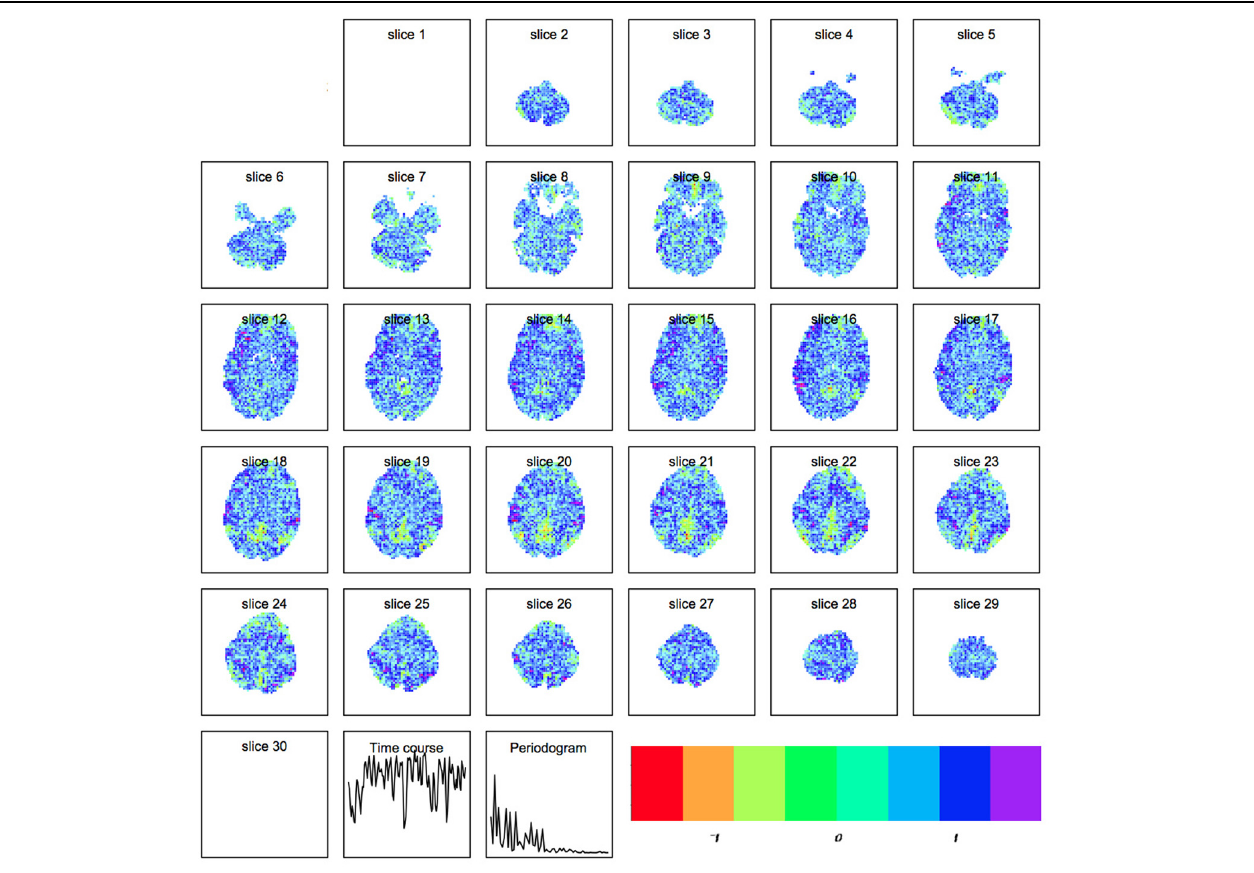
FIGURE 2 | Spatial map produced by independent components analysis within R. Each component is a set of spatially weighted regions modulated by the time course. The total longitudinal contribution of a component to the activity observed is the spatial map multiplied by the